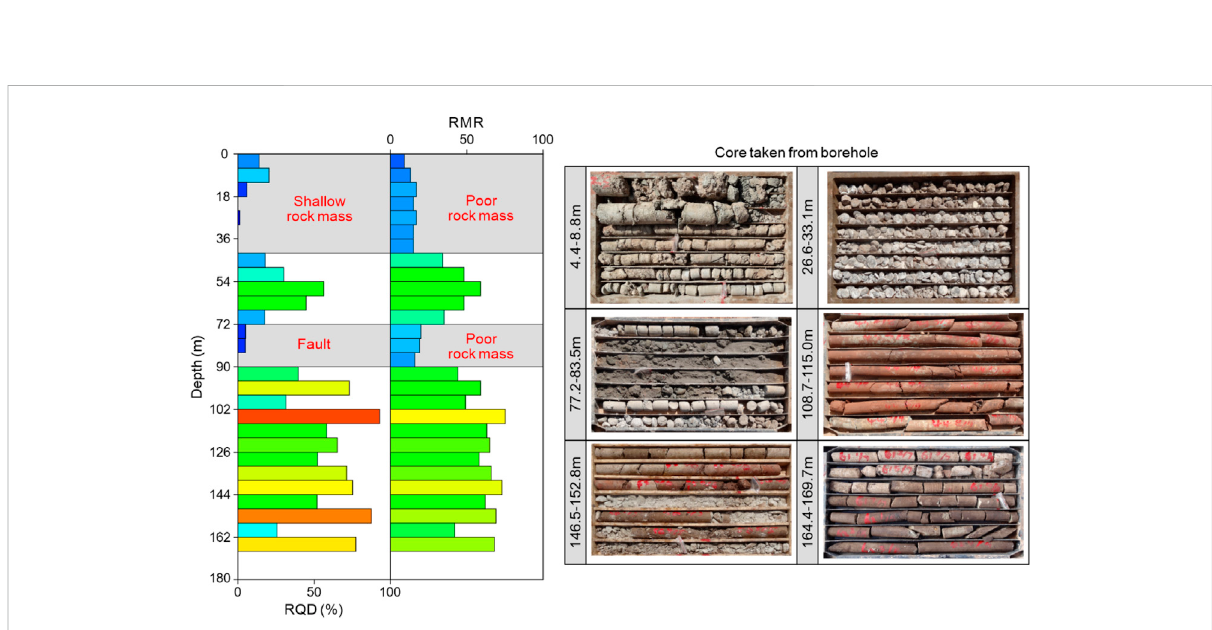
FIGURE 6 Borehole investigation in the Fushun West Open-Pit coal